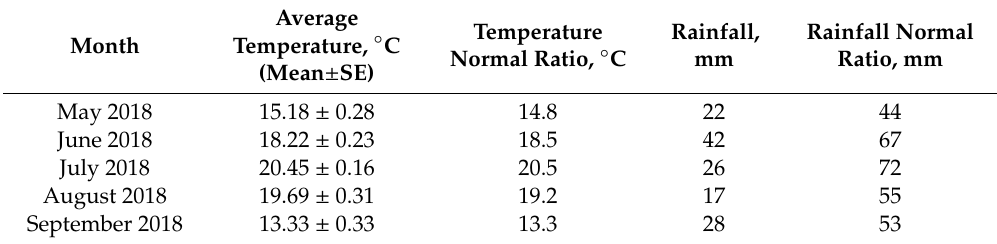
Table 2. Meteorological data for the growing season 2018 in Voronezh Region (51.650, 39.250) adapted in http: // pogoda-service.ru / climate_table.php.